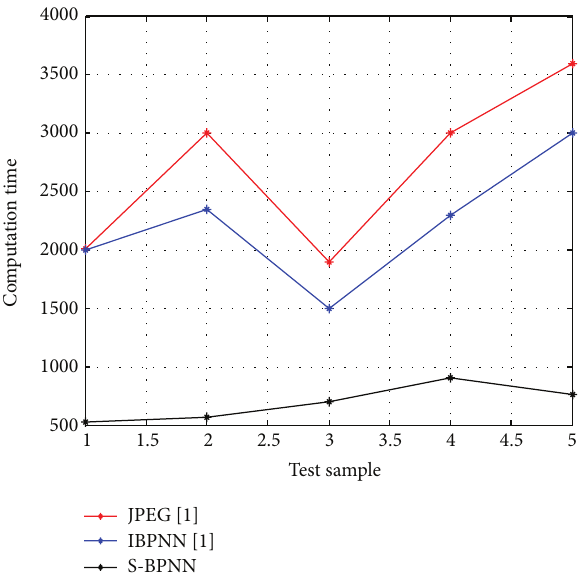
Figure 7: Comparison of computation time in milliseconds when the three methods are